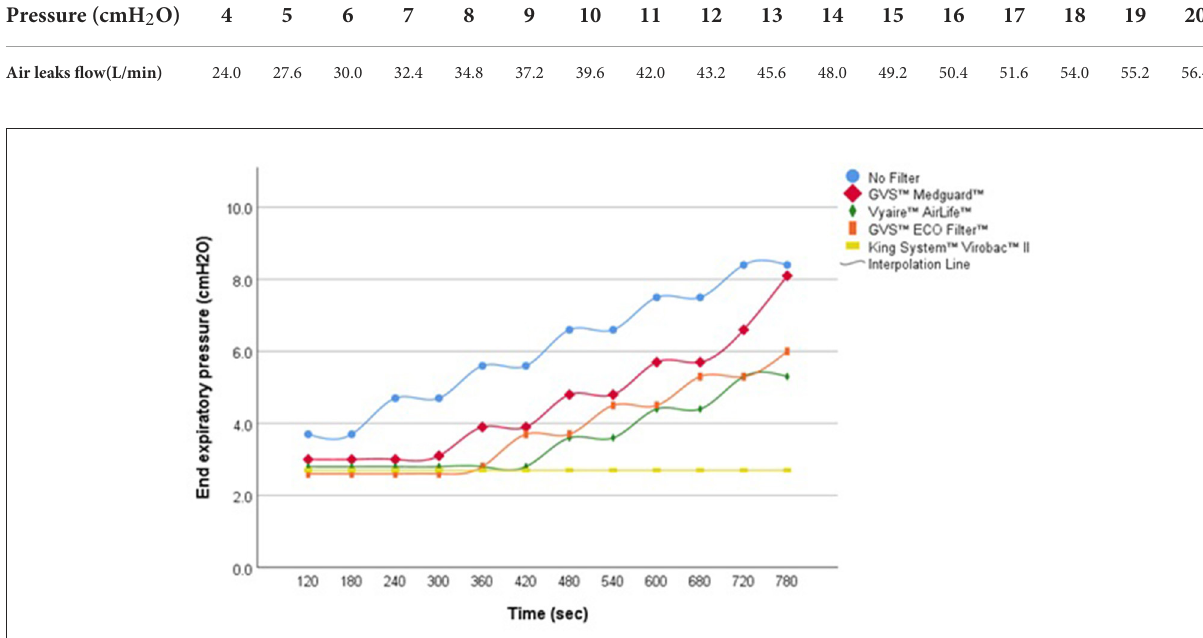
TABLE 1 Air leaks flow of the UIAL valve according to device set pressure level.